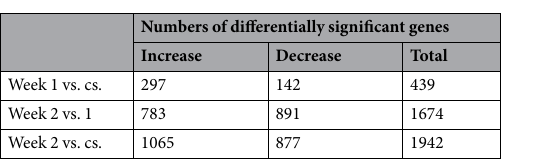
Table 1. Numbers of statistically significant differentially regulated